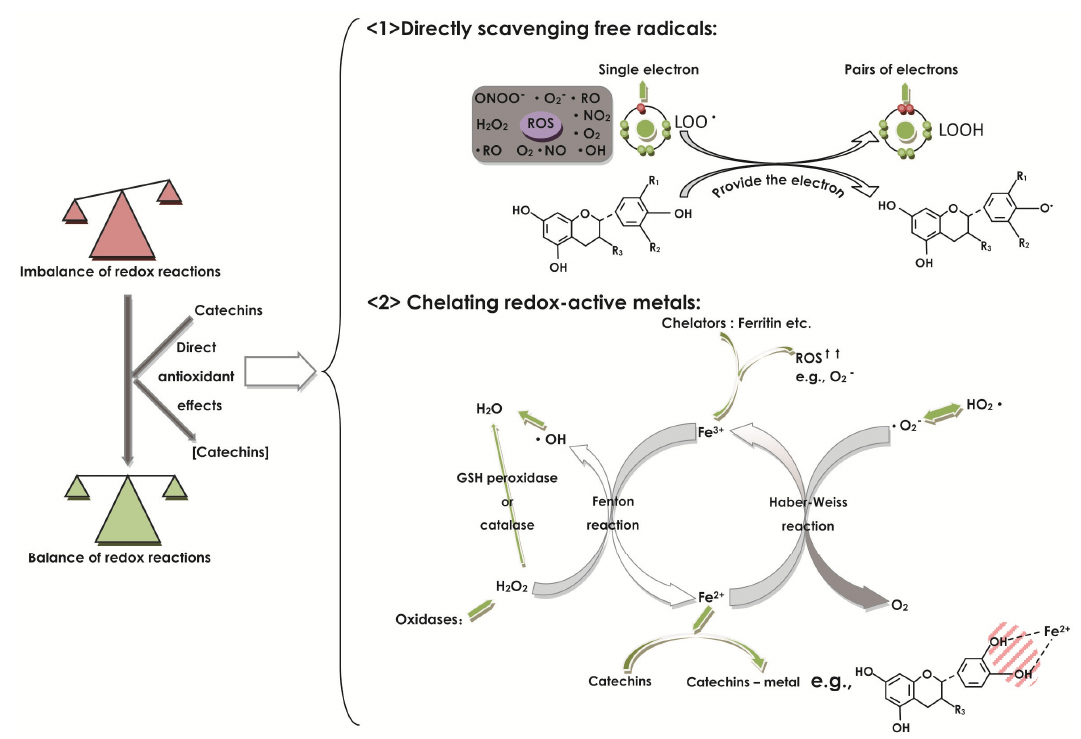
Figure 4. Catechins can exert direct antioxidant effects by reacting with free radicals to disrupt the free radical chain reaction and chelating redox-active